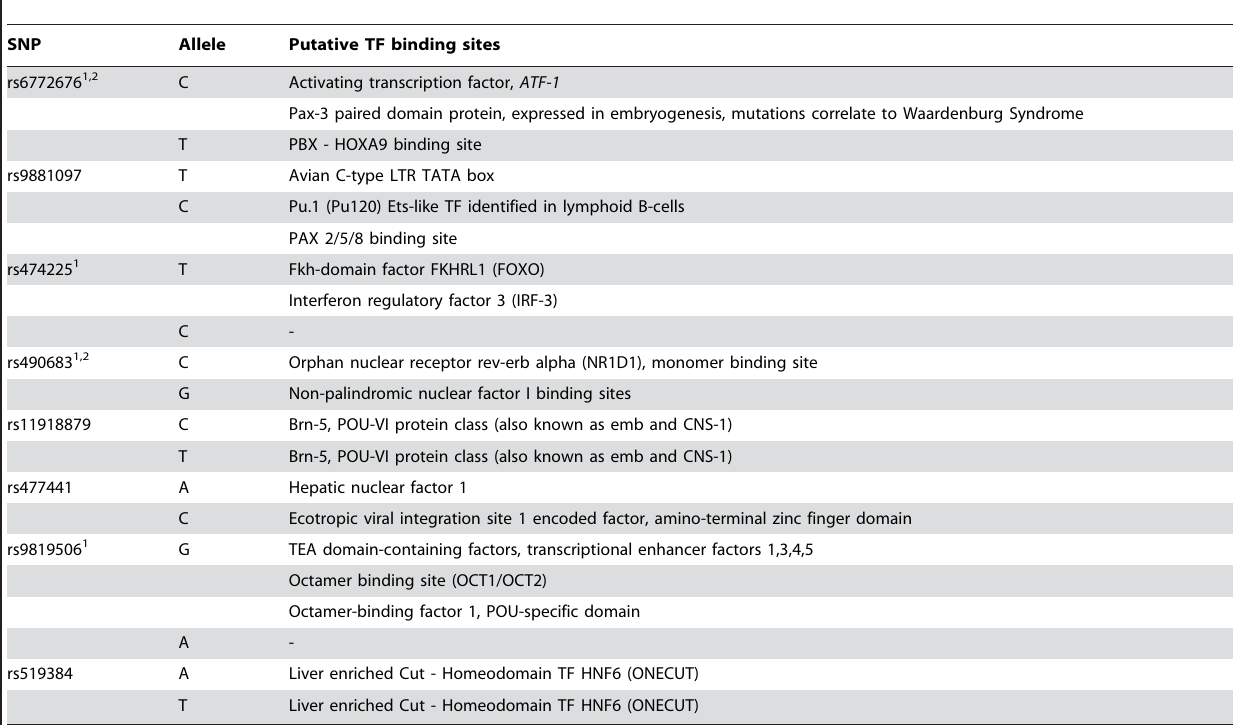
Table 2. Single nucleotide polymorphisms (SNPs) in the GHSR promoter and putative transcription factor (TF) binding sites.